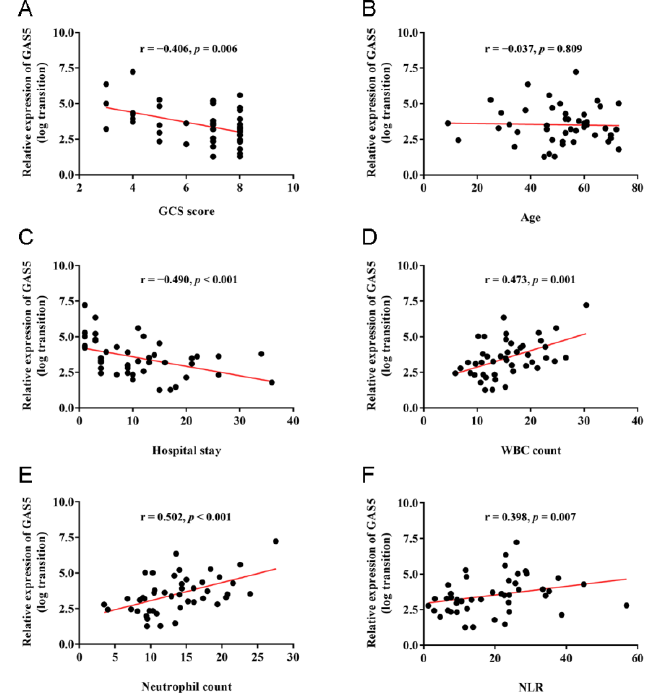
Figure 2. Correlations of plasma GAS5 expression with clinical and inflammatory parameters in TBI patients: ( A ) GAS5 versus GCS score; ( B ) GAS5 versus age; ( C ) GAS5 versus the length of hospital stay; ( D ) GAS5 versus white blood cell count; ( E ) GAS5 versus neutrophil count; ( F ) GAS5 and neu- trophil/lymphocyte ratio. Spearman correlation coefficient (r) and p values are listed above each